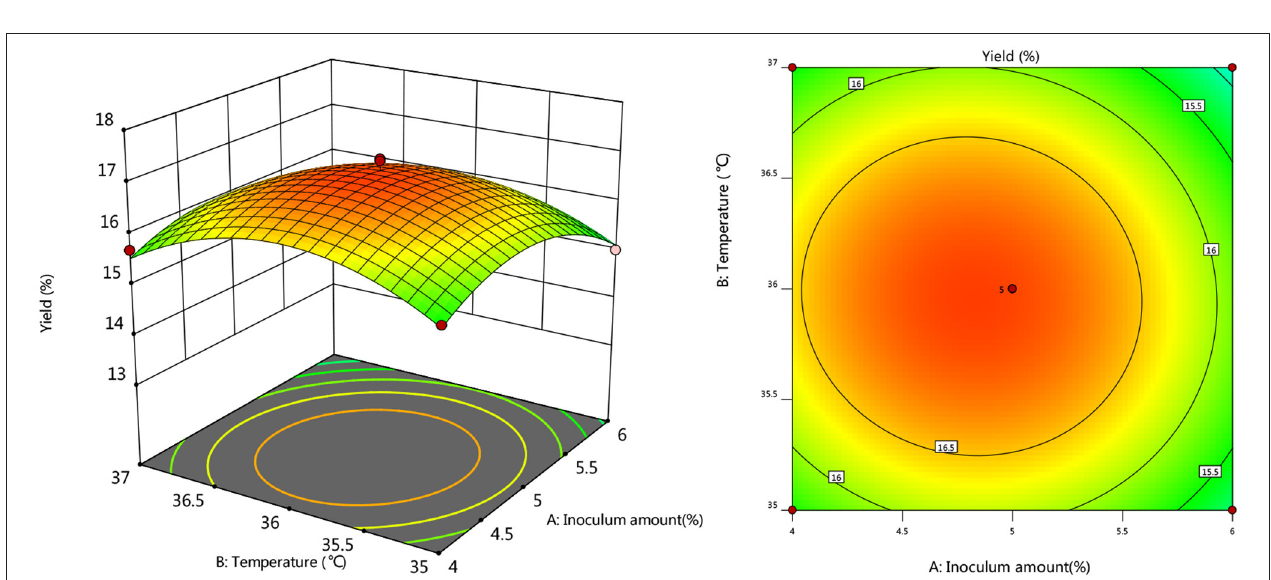
FIGURE 6 | Response plot of the interaction between inoculum and temperature on yield.